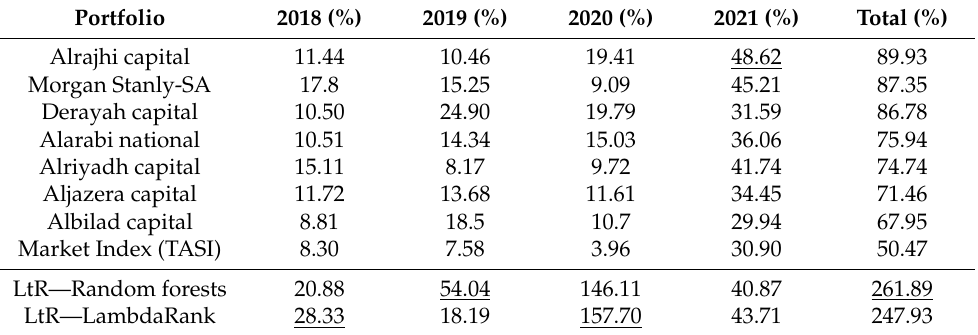
Table 9. The performance of the best performing hedge funds managed by investment firms in Saudi Arabia. Returns are compared with the top two performing simulated LtR portfolios for the period from January 2018 to December 2021. Underlined values represent the portfolio with the highest